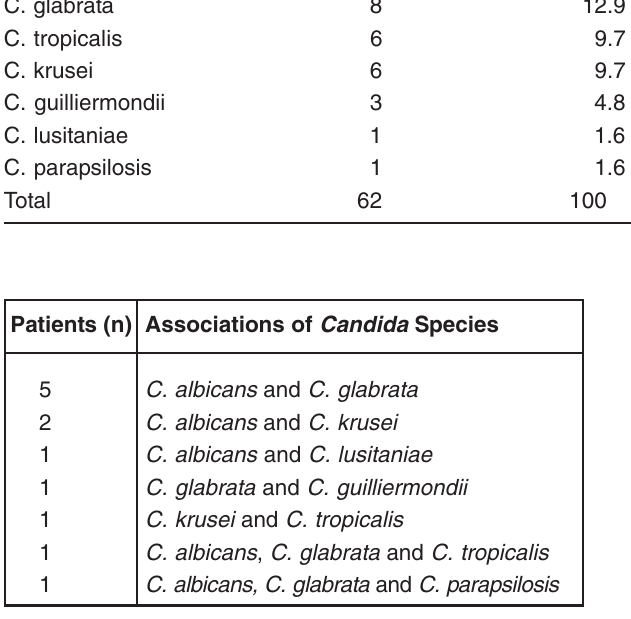
FIGURE 1- Associations of Candida species isolated from complete upper denture wearers, before the use of